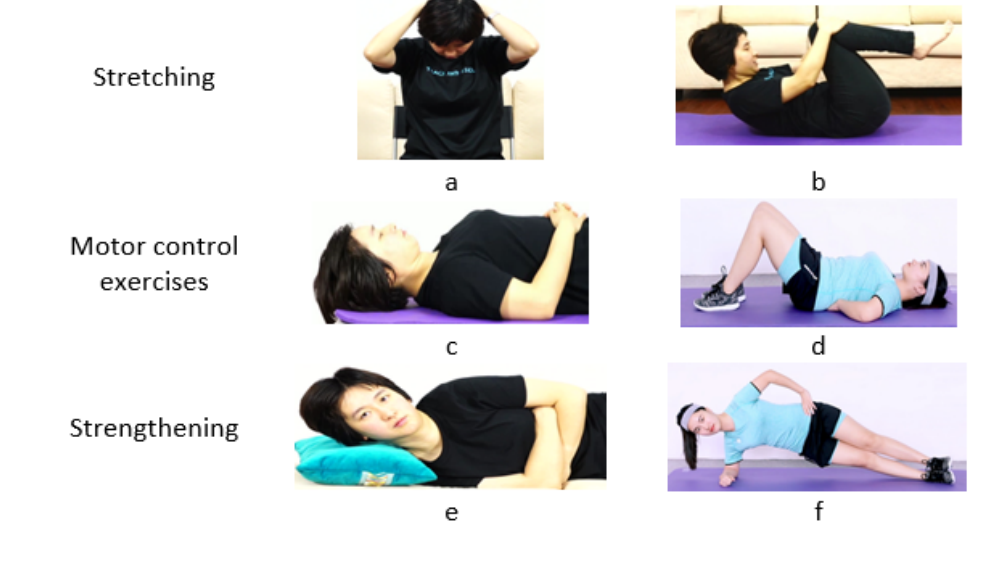
Figure 2. The architecture of the multilayered perceptron artificial neural network used in this